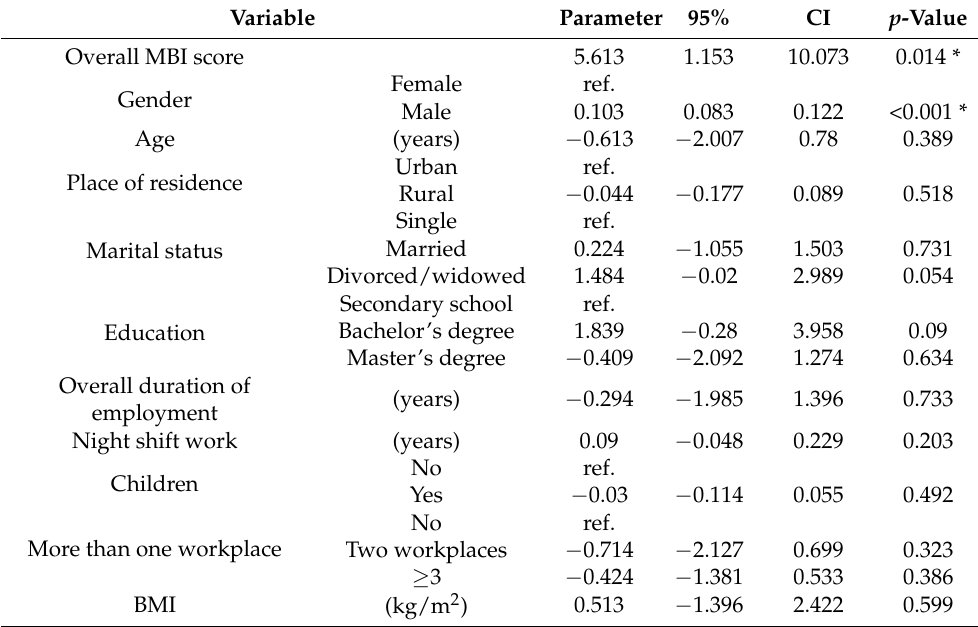
Table A2. The multifactorial linear regression of the Athens Insomnia Scale (AIS).